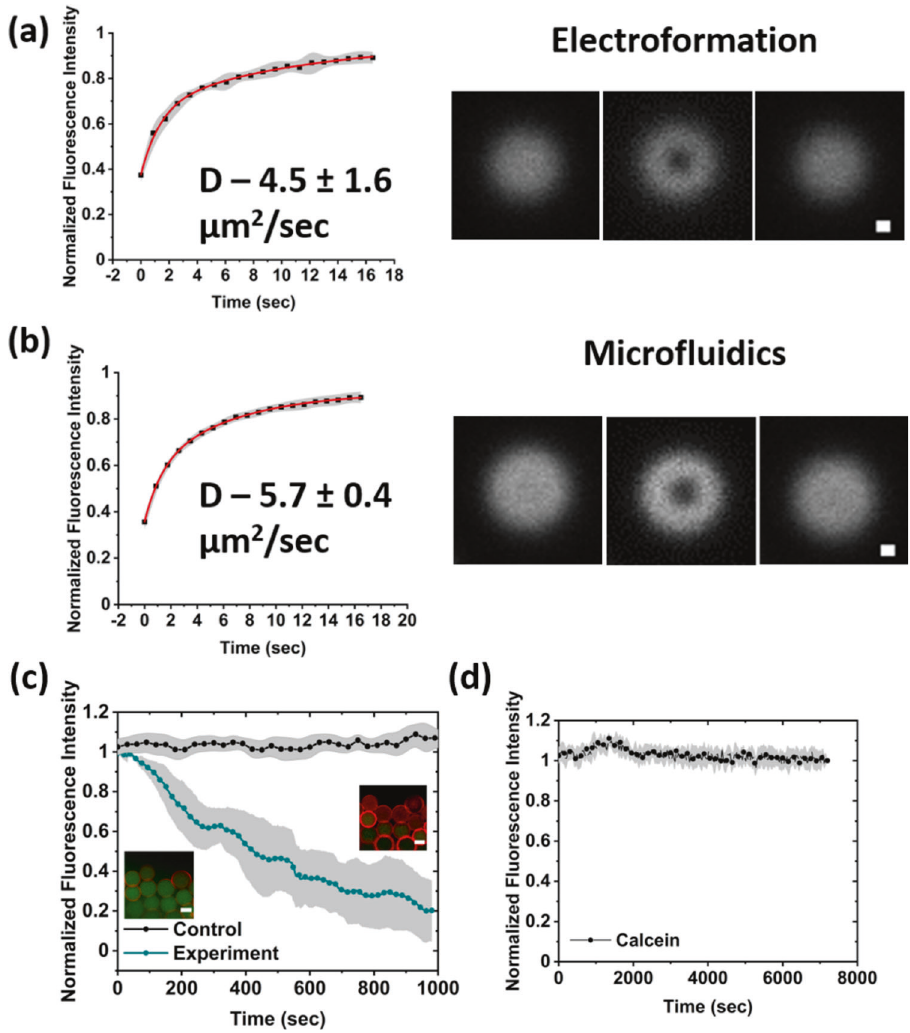
Fig. 4 Purity and stability of the lipid membranes. Average fl uorescence recovery curves (left) of at least 15 GUVs produced using a electroformation and b micro fl uidics along with the confocal cross-sections before ( − 2.5 s), during, and after (18 s) photobleaching (right). Scale bars: 3 µ m. c A calcein dye- leakage assay using α -hemolysin protein insertion with a gradual decrease in mean luminal fl uorescence intensity over time from vesicles with an average diameter of 60 µ m ( n > 10). Scale bars: 60 µ m. d Plot showing the vesicle stability over time with no decrease in the mean calcein fl uorescence intensity ( n > 10). Error bars are taken from the standard deviation of the